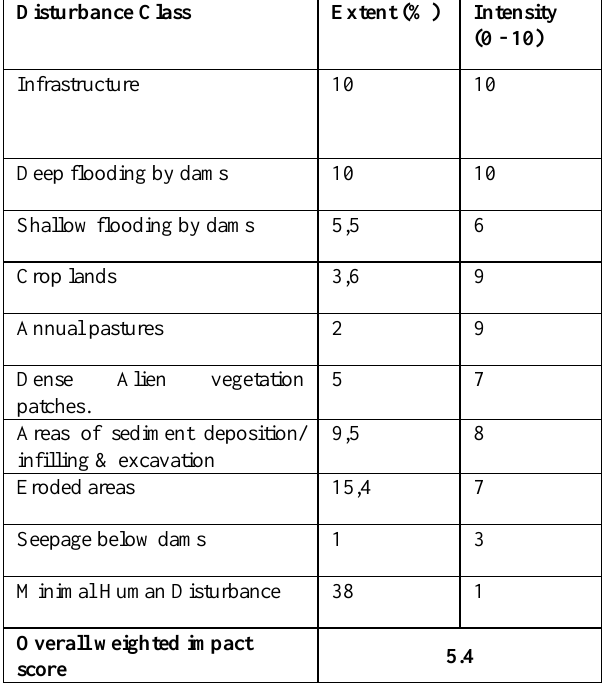
Table 8. WET-Health vegetation module completed for the on- site